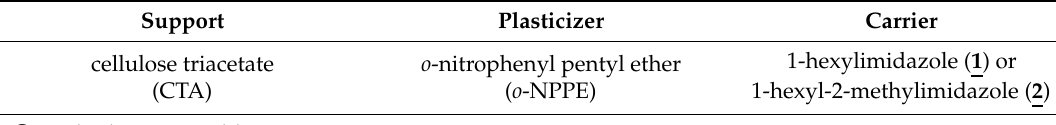
Table 1. The composition of the membrane used.